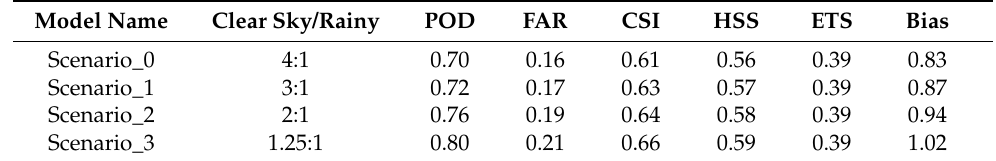
Table 4. Validation scores under four scenarios with different proportions of clear sky pixels to rainy